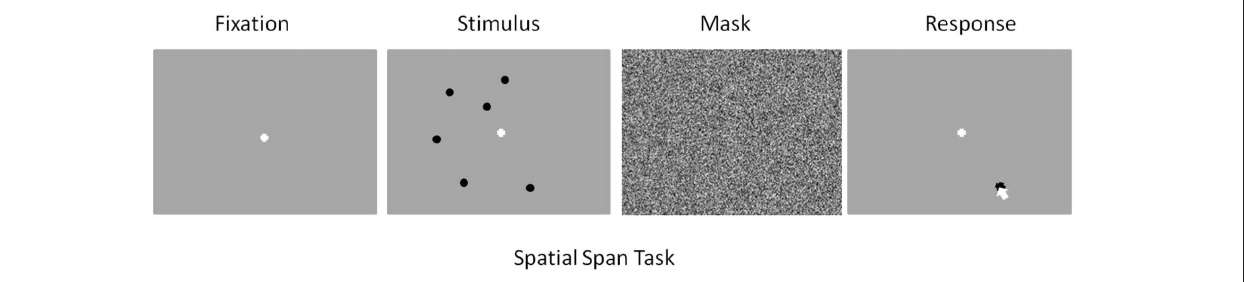
Frontiers in Human Neuroscience |